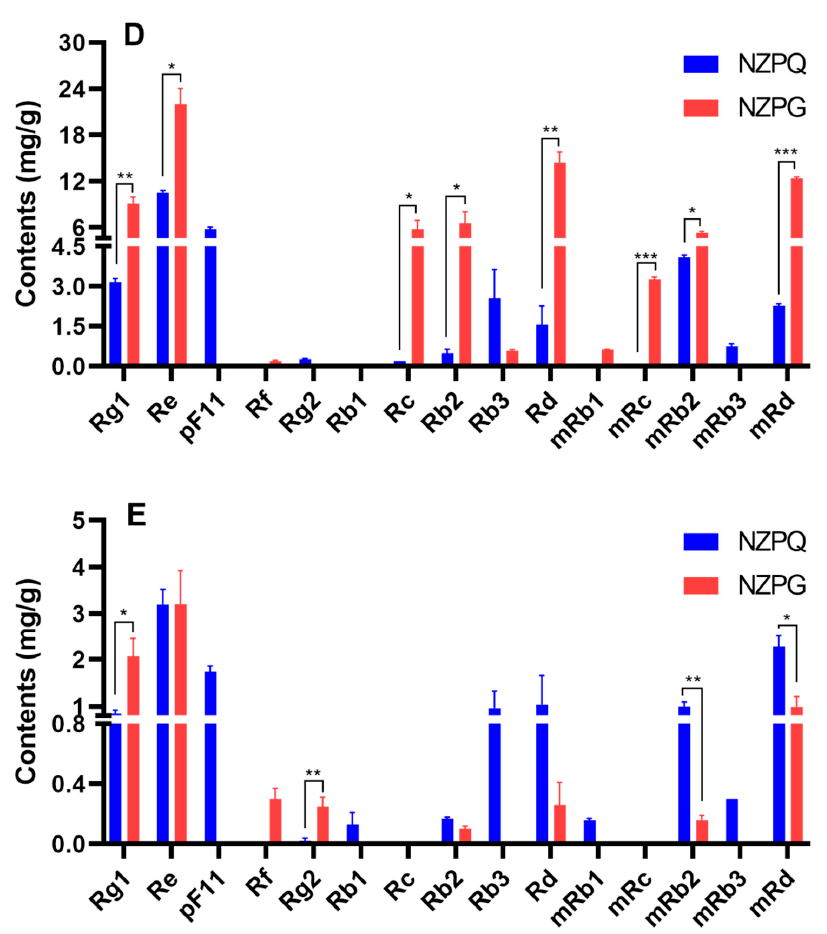
Figure 6. The ginsenoside contents from di ff erent parts of NZPQ and NZPG. ( A ) Fine root; ( B ) rhizome; ( C ) main root; ( D ) leaf; ( E ) stem. Data were expressed as mean ± SD and analyzed by t-test using Graph pad 8 software. * p < 0.05, ** p < 0.01, *** p < 0.001. Di ff erences were considered significant if p <